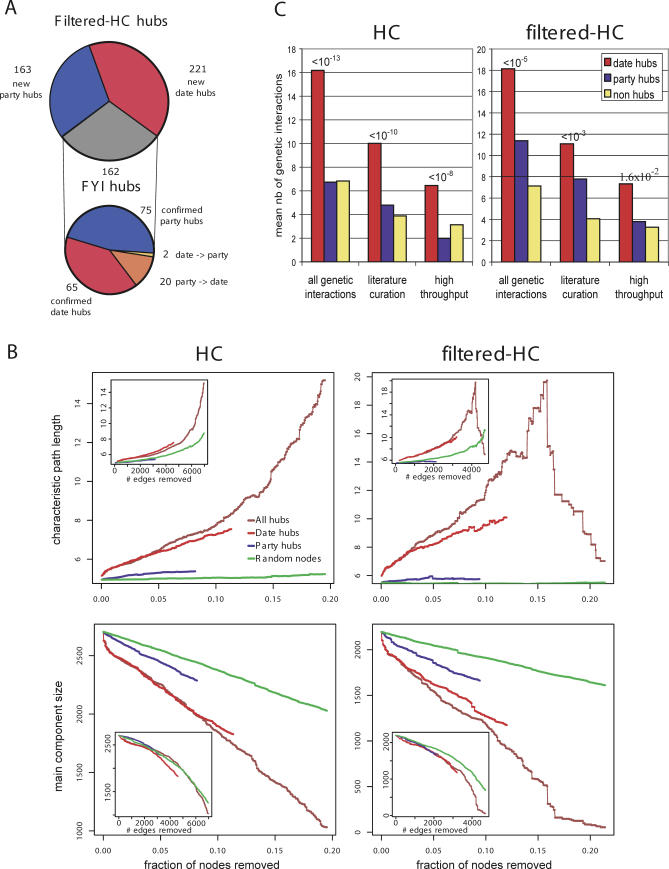
Analysis of Hub Properties in the Filtered-HC and HC Interactome Networks(A) Consistency of the party/date attribution between FYI and filtered-HC. Because filtered-HC network has many more interactions than FYI, only 162 of the 546 hubs in filtered-HC had been previously found in FYI. Filtered-HC confirmed 86% of the party/date designations in FYI. In addition, 20% of FYI hubs are not considered as hubs anymore in the new filtered-HC network because of the higher connectivity threshold.(B) The effect on the characteristic path length (top panels) and main component size (bottom panels) of the networks upon gradual node removal for HC (left panels) and filtered-HC (right panels). Attacks against all hubs (brown curve), party hubs (blue curve), date hubs (red curve), and random nodes (green curve). Insets show an additional control for connectivity differences between categories with the x-axis representing the number of edges removed from the network.(C) Date hubs participate in more genetic interactions than party hubs or non-hubs [2], as measured here by mean number of interactions [1] from a network of curated genetic interactions [32] for both filtered-HC (right panel) and HC (left panel). Inside each panel, bars show the number of genetic interactions held by date hubs (red), party hubs (blue), and non-hub proteins (yellow). The p-values assessing the difference of the means between date and party hubs (Mann-Whitney U-test) are indicated above the bars.